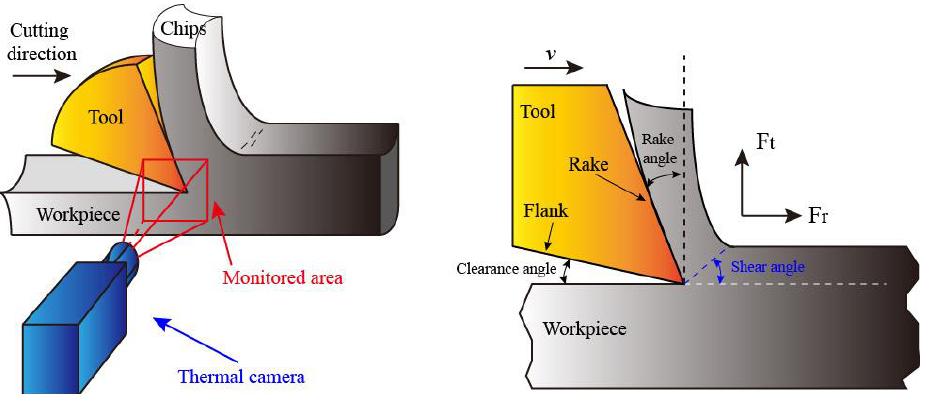
Figure 3. The arrangements for temperature capturing and the indication of the tool–workpiece in- teraction.